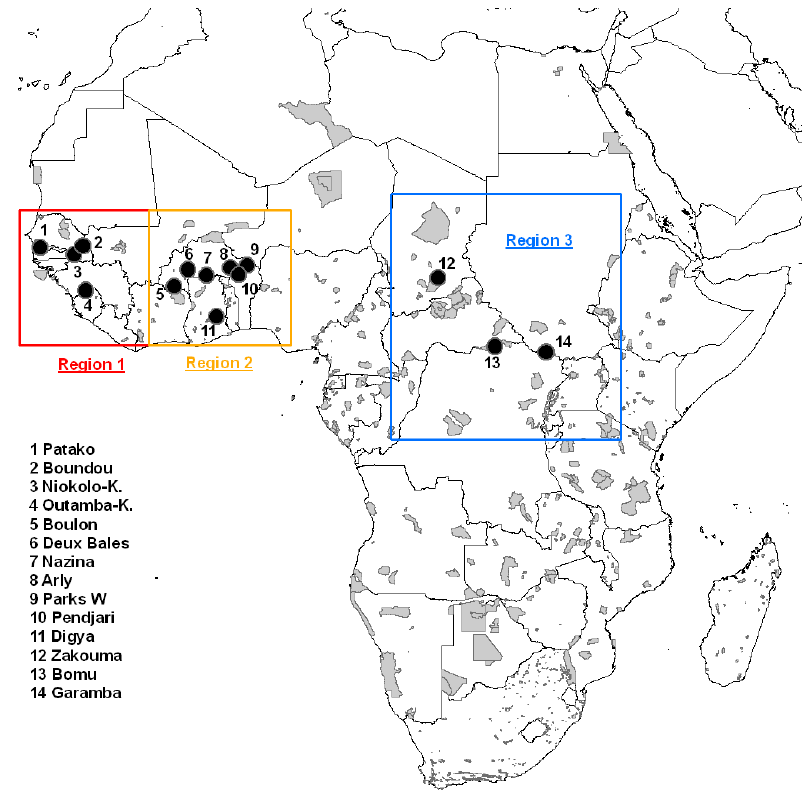
Figure 1. Location of the three regional windows and of the protected areas (black circles) considered in the